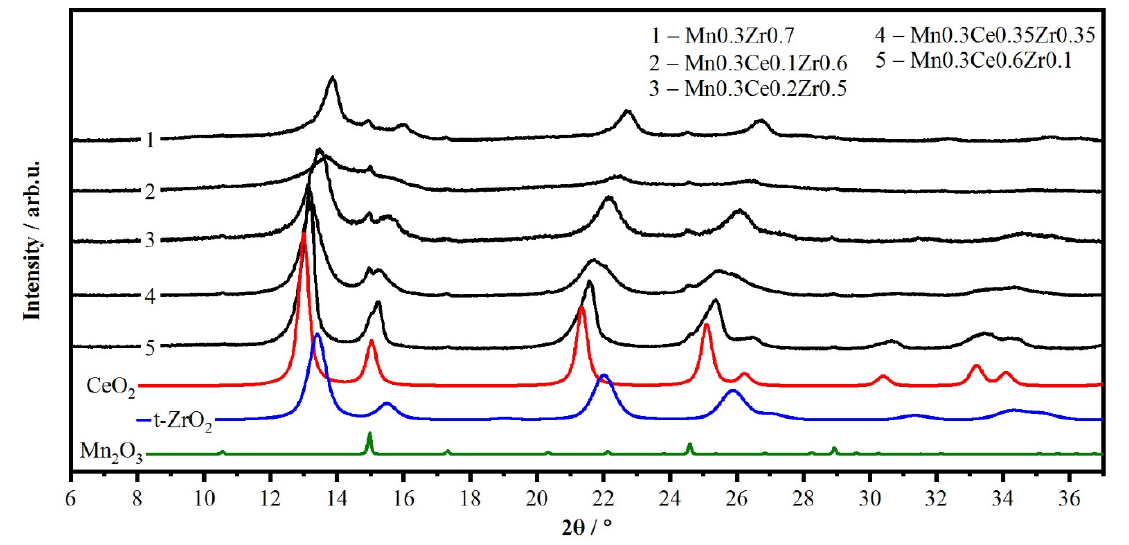
Figure 4. XRD patterns of Mn0.3(Zr,Ce)0.7 catalysts and peak positions of phases CeO 2 (PDF No.